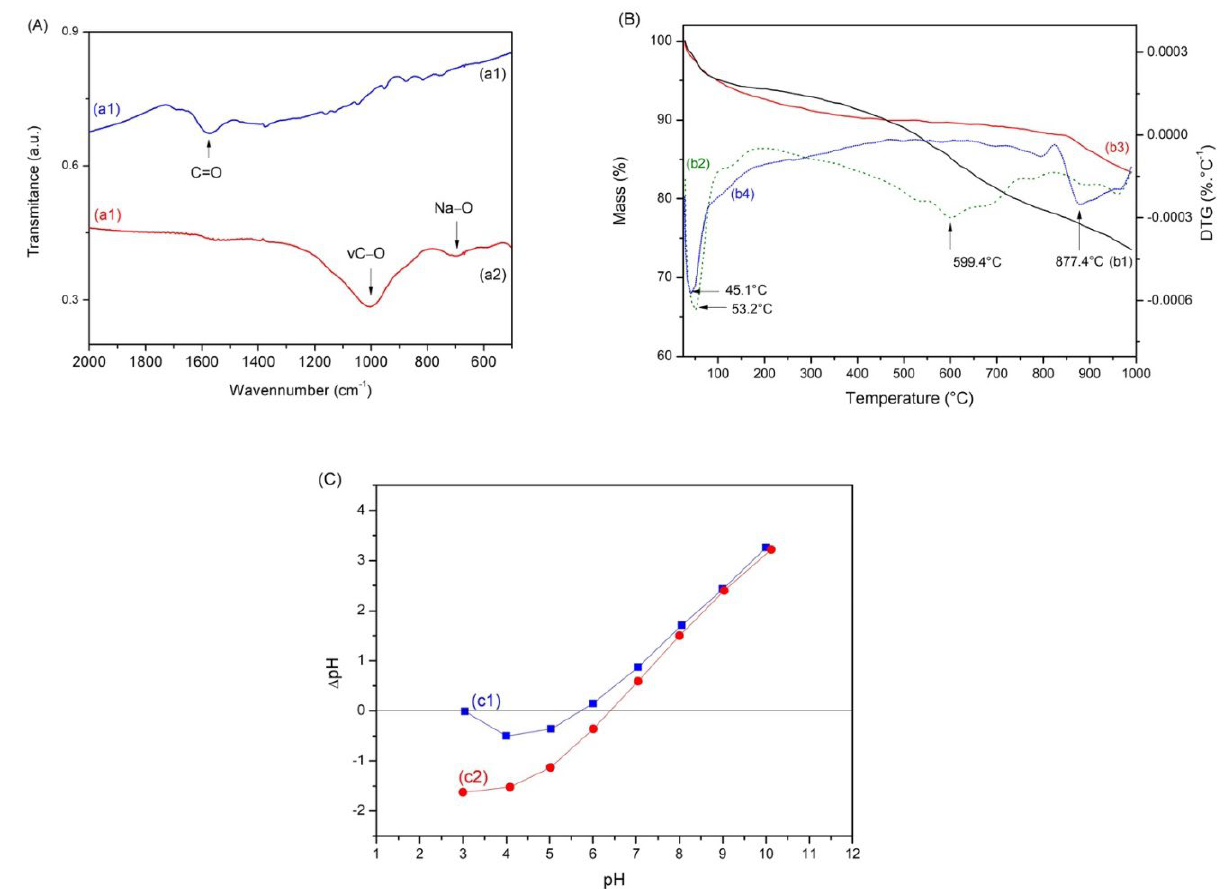
Figure 1. FTIR ( A ) for the studied biochar (BE) (a1) and biochar (ABE) (a2) ( B ); TG and DTG ( B ) curves for the studied samples of biochar (BE), (b1) and (b2), respectively, and curves for the studied samples of biochar (ABE) (b3) and (b4), respectively; ( C ) pH PZC result for the studied samples of biochar (BE) (c1), and biochar (ABE) (c2).